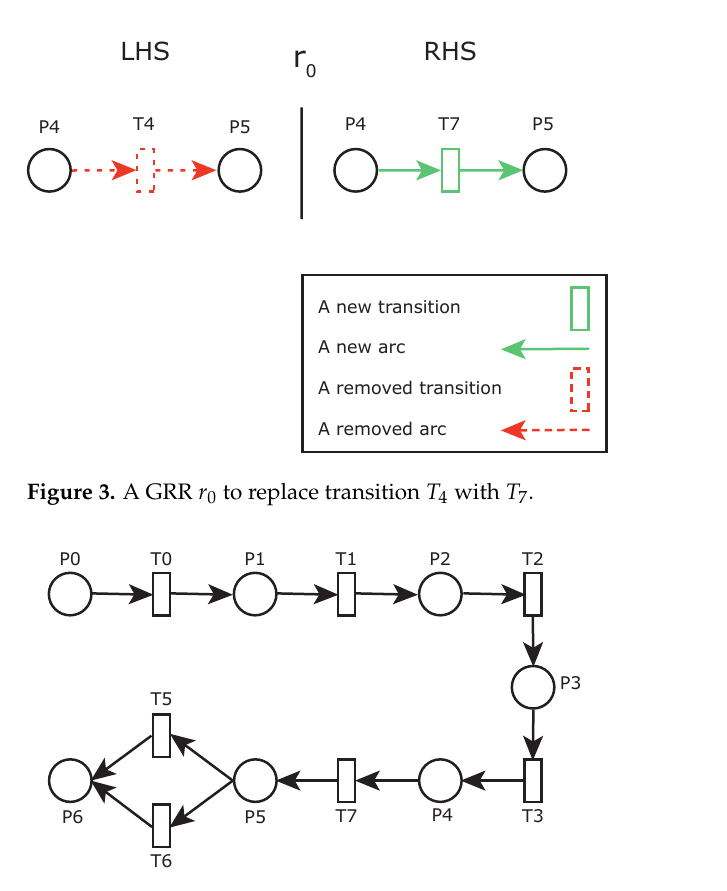
Figure 4. The rewritten structure of the grading